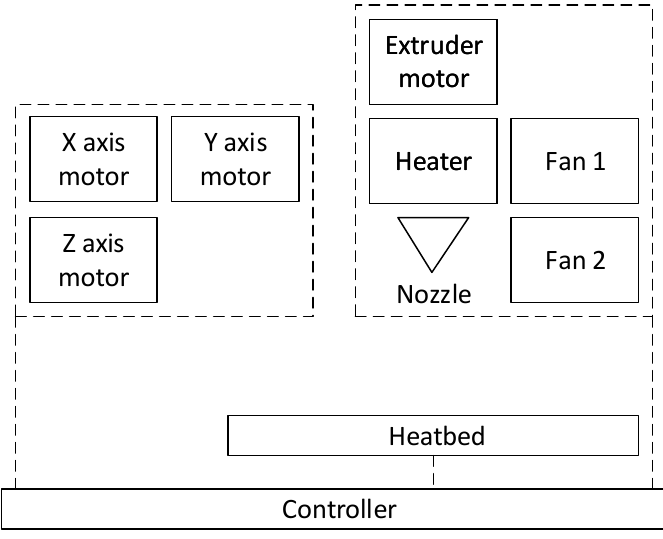
Figure 3. Structure diagram of 3D